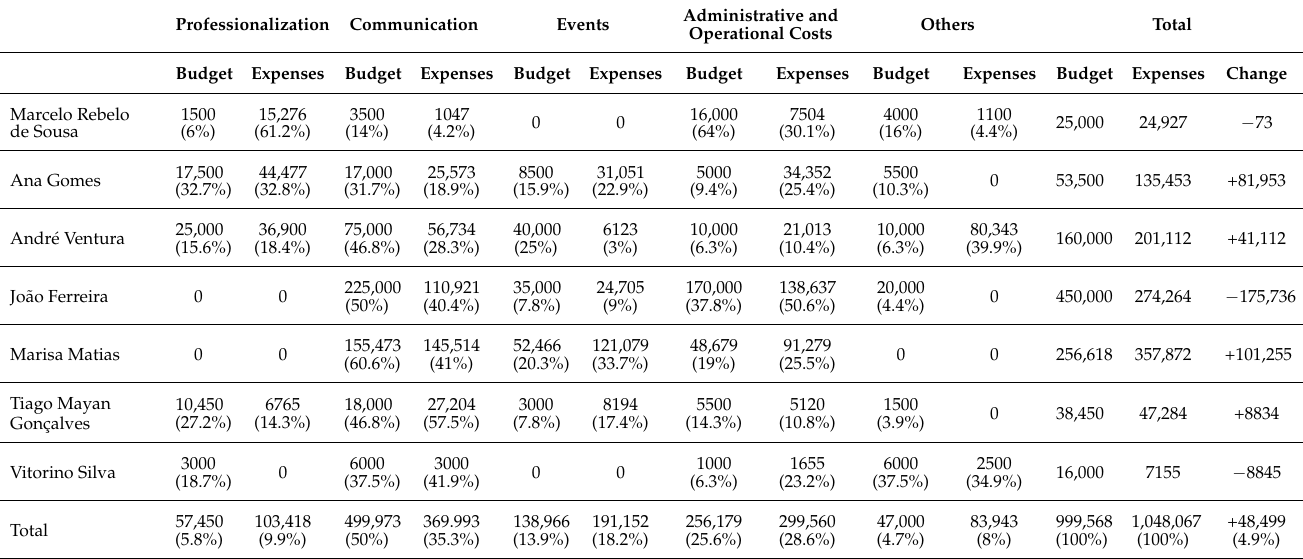
Table A1. Planned investment and actual expenses in the 2021 Presidential election campaigns.